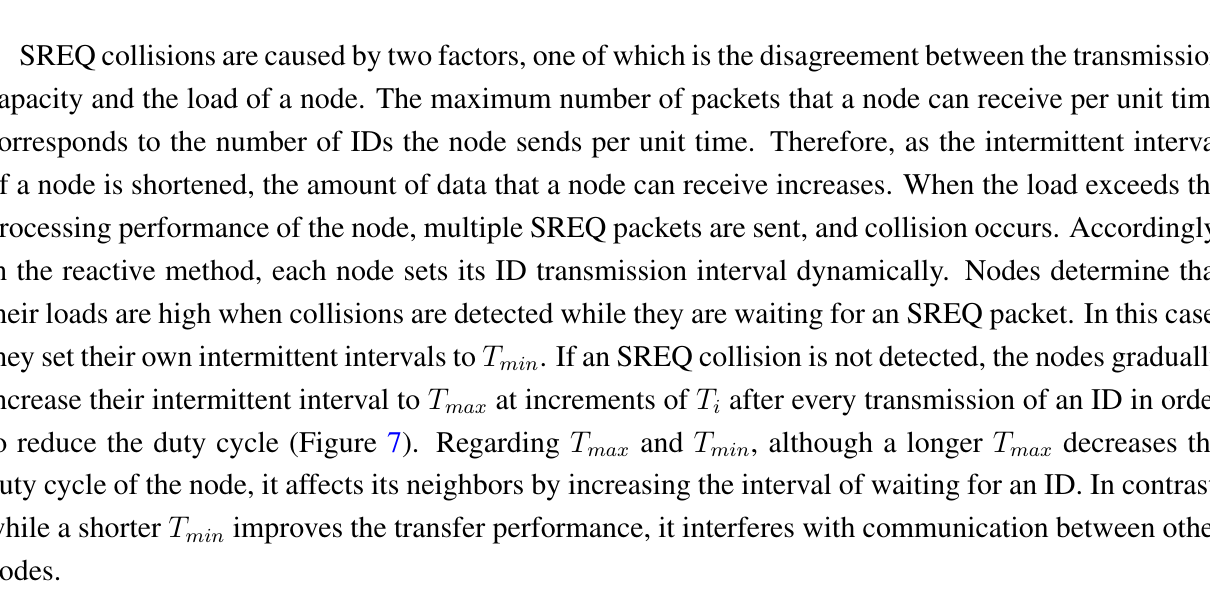
Figure 7. Dynamic control of the intermittent interval as proposed in